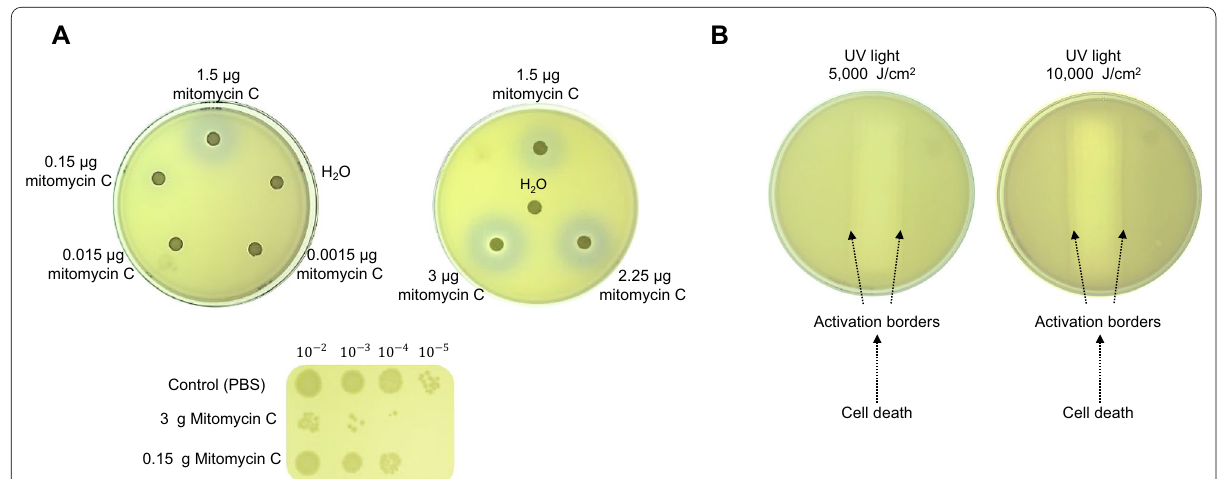
Fig. 2 Reporter strain characterization with mitomycin C. A shows different concentrations of mitomycin C applied to the plate using sterile paper disks. Plates show low and high mitomycin C concentrations. In the lower panel, cell viability was assessed by spot assay shown at high and low concentrations of mitomycin C. The control spot contained sterile water. B shows the effect of UV light exposure through a 1 mm slit. Two UV‑light intensities were used. The clear area on each experiment indicates cell death. The purple halos indicate reporter strain